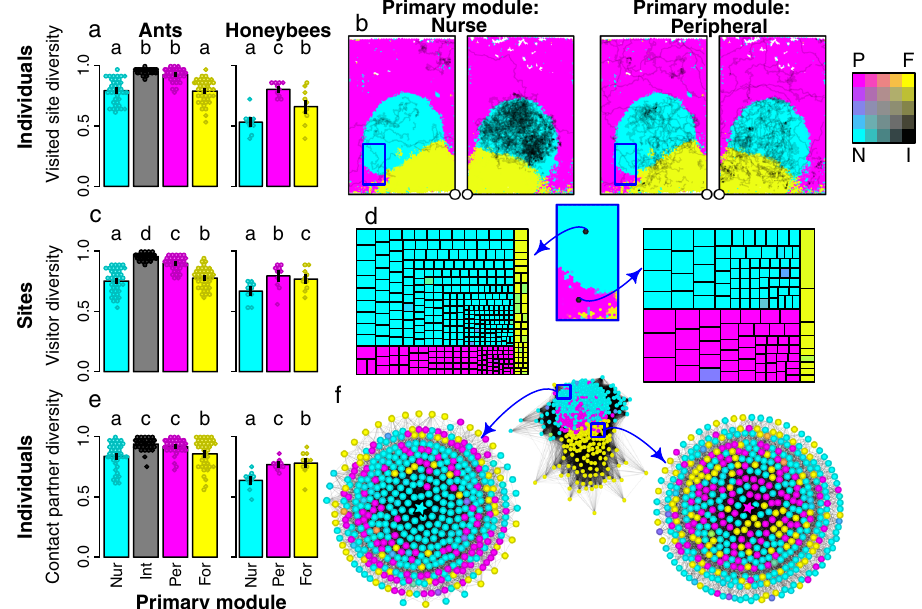
Fig. 4 | Quantifying the diversity of visited sites, site visitors, and contacted nestmates. Barplots show the module score diversity of the sites an individual visited, D visited , i ( a ),ofthevisitorstoagivensite,D visitor , s ( c ),andofthenestmatesanindividualphysicallycontacted,D contacted , i ( e ).Diversitywasquanti fi edasanentropicmeasure of heterogeneity, ranging from 0 (all visited sites, visitors, or contact partners belong to the same module) to 1 (even representation of visited sites, visitors, or partners from all modules). Points represent colony means. Bars & whiskers indicate the grand means and standard errors. Letters above bars indicate BH corrected post-hoc contrasts, derived from linear mixed-effect models (LME) predicting diversity by module. Colony identity was used as a random effect in all models. Models were fi tted separately for the ants and the bees because they differed in the identity of their modules. D visited , i ~module, honeybees: χ 2 =1764.0, d.f.=2, p <0.0001; ants: χ 2 =895.8, d.f.=3, p <0.0001; post-hoc contrasts, ∣ z ∣ ≥ 18.8, p <0.0001 in all cases. D visitor , s ~module, honeybees: χ 2 =30121, d.f.=2, p <0.0001; ants: χ 2 =58279, d.f.=3, p <0.0001; post-hoccontrasts, ∣ z ∣ ≥ 13.2, p <0.0001inallcases.D contacted , i ~module,honeybees: χ 2 =3497.2,d.f.=2, p <0.0001;ants: χ 2 =680.2,d.f.=3, p <0.0001;post-hoccontrasts, ∣ z ∣ ≥ 8.4, p <0.0001 in all cases. b Three-day trajectories for an example nurse (left) and peripheral (right) honeybee workers on both sides of the wax comb. The circles indicate the nest entrance. d Worker visitation patterns for the two example focal sites indicated in the module map blow-up (left: nurse site; right: peripheral site). Visitationpatternsrepresentedastreemaps;eachrectanglerepresentsaworkerthatvisitedthefocalsiteatleastonce.Rectangleareasareproportionaltothenumberof visitsbyaworkertothesite.Coloursencodeeachworker ’ smodulescores(CMYKcombination).Rectanglesaregroupedtogetheraccordingtoworkers'primarymodule. f The middle network shows the daily contact network, in which nodes represent individuals, and weighted edges the number of physical contacts between bees. Node positionsaredeterminedbyaforce-directedlayout.Theleftandrightplotsshowego-centriccontactnetworksforanurse(left)andaperipheralbee(right),indicatedby the central stars. The distance from each node to the focal bee indicates the number of contacts with the focal bee. Source data are provided as a source data fi